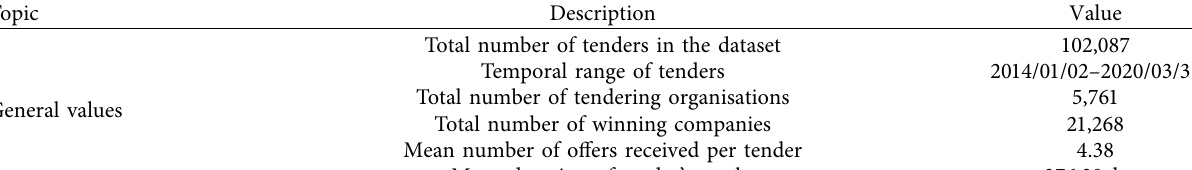
Table 3: Quantitative description of the tender dataset.